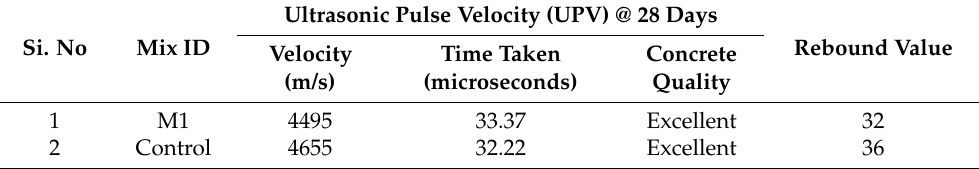
Figure 6. Nondestructive test setup. Table 7. Results of UPV and rebound hammer test.